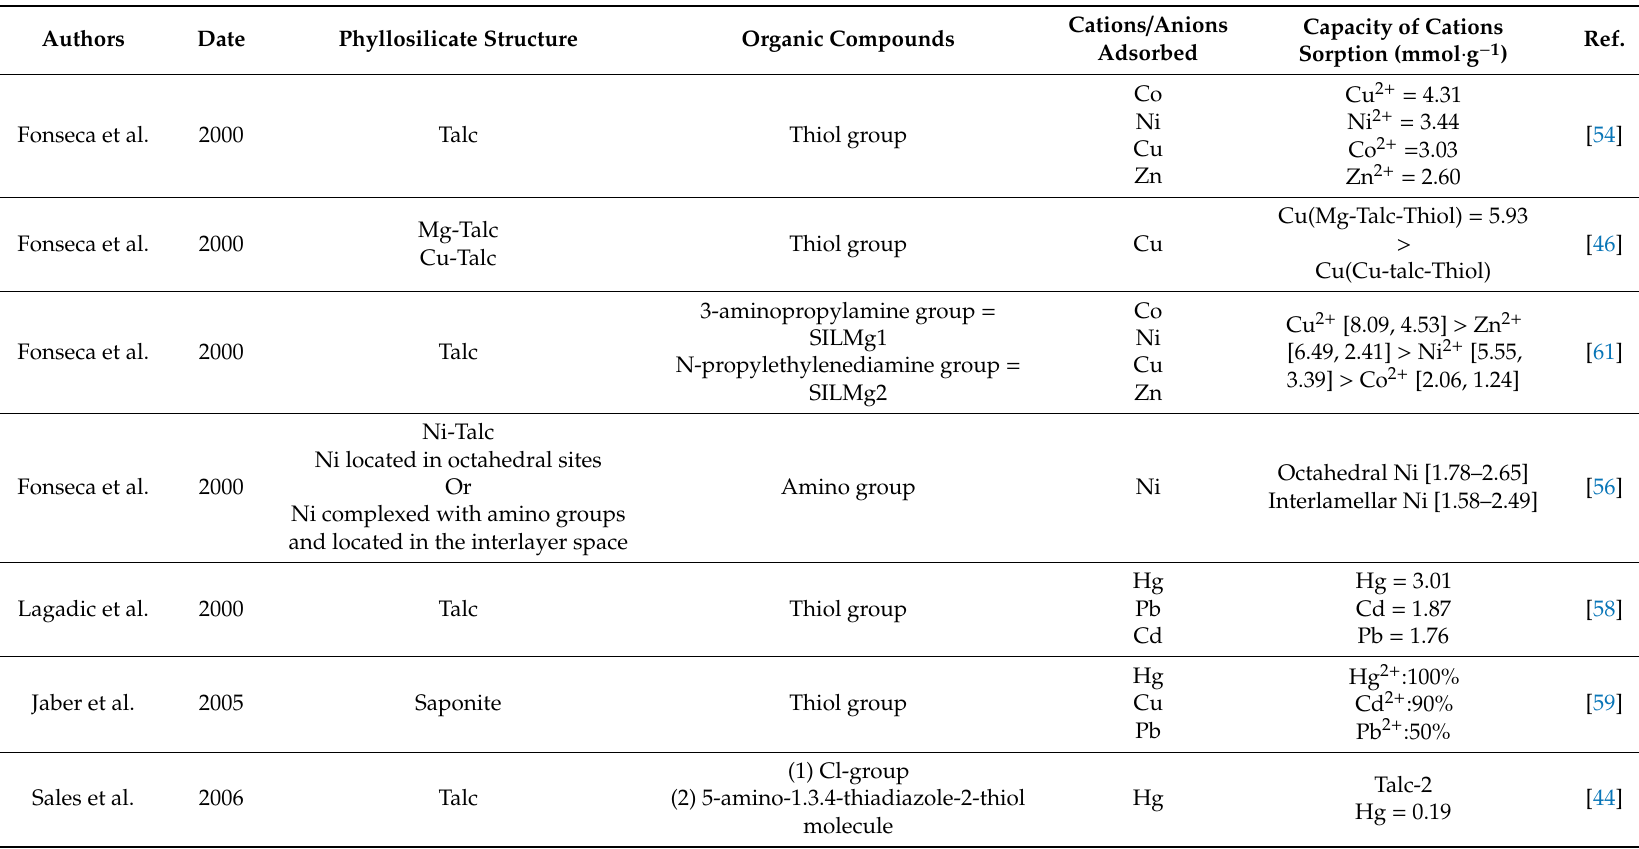
Table 2. List of synthetic organic–inorganic hybrids having a phyllosilicate-like structure investigated for their adsorption characteristics with various heavy